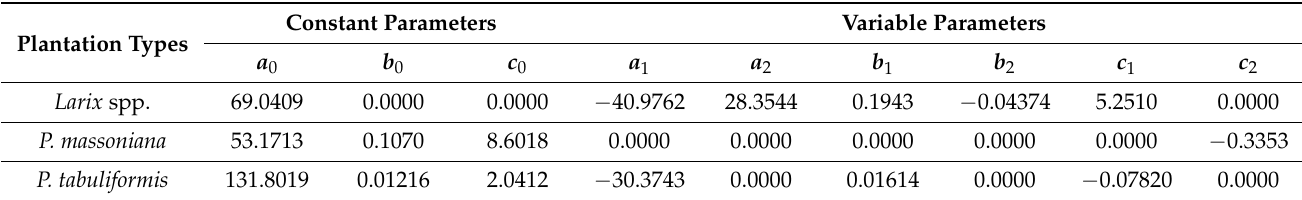
Table 3. Parameter estimates of Model (3).